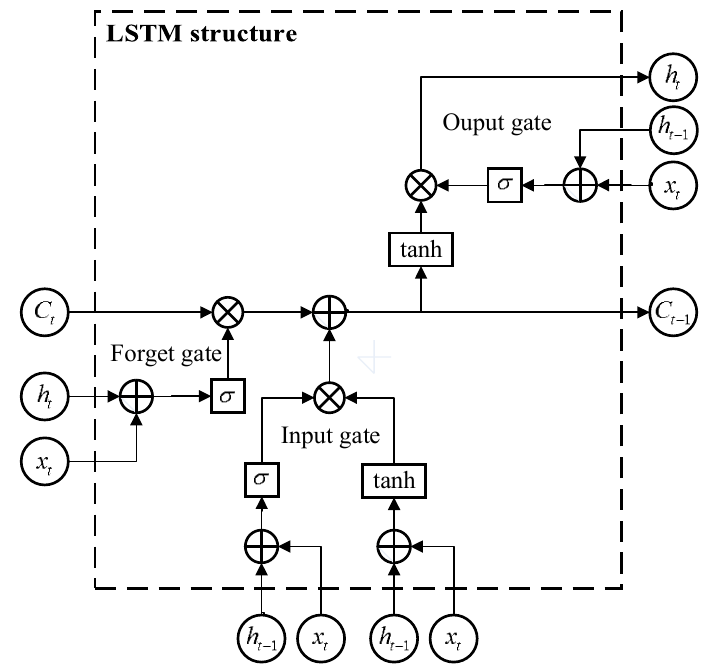
Figure 2. LSTM structure.